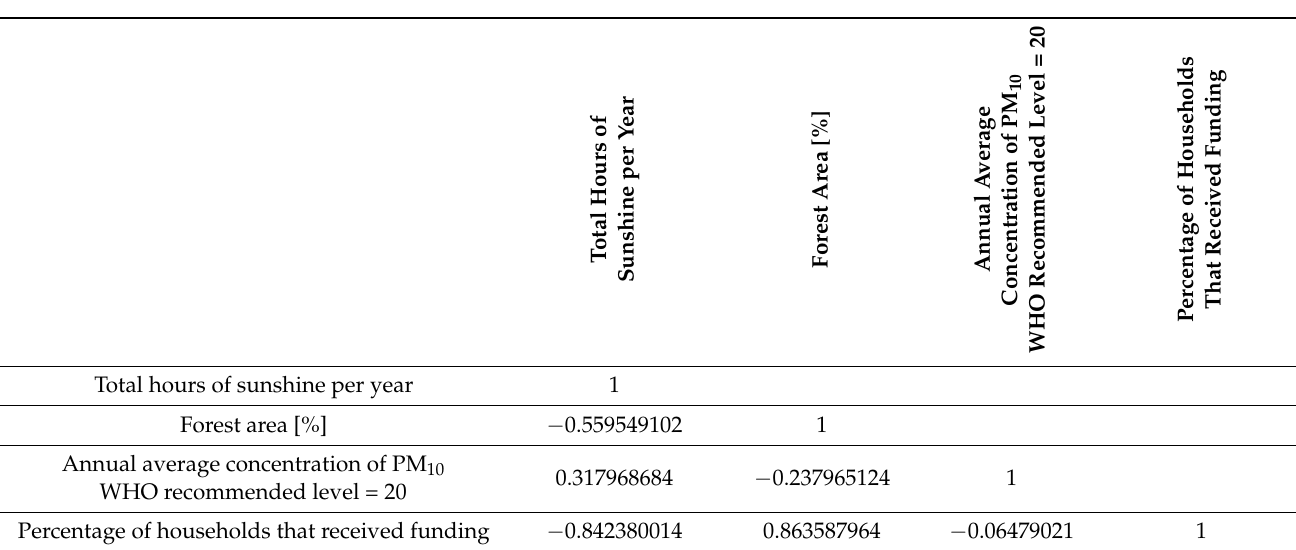
Table 2. The Location Correlation